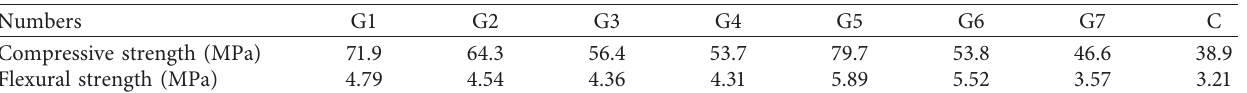
Table 7: Compressive strength and flexural strength of each specimen cured for 28 days at room temperature.